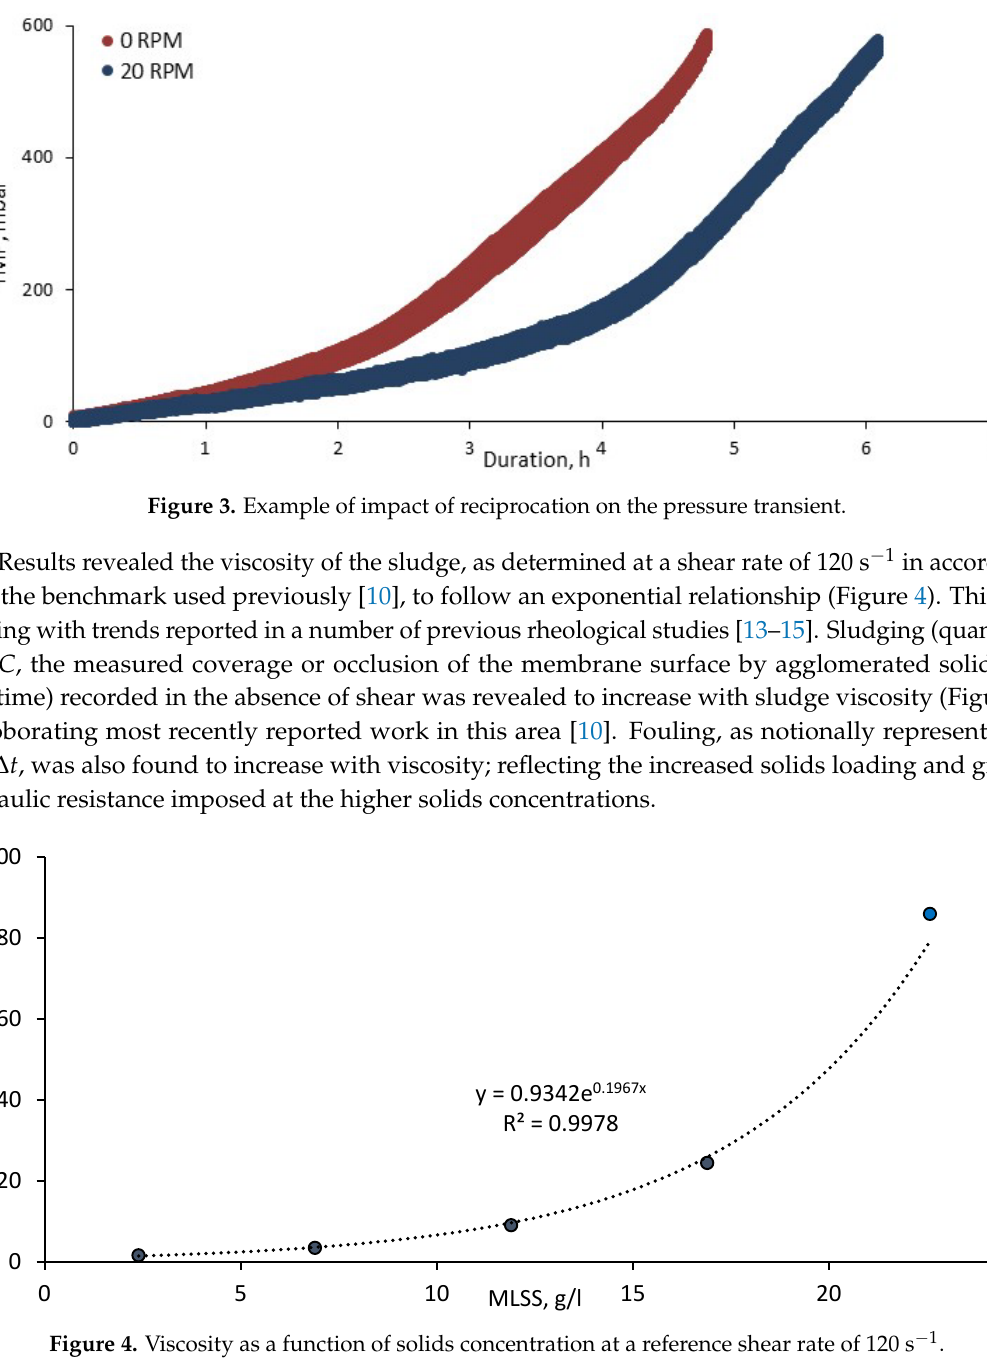
Figure 4. Viscosity as a function of solids concentration at a reference shear rate of 120 s −1 .